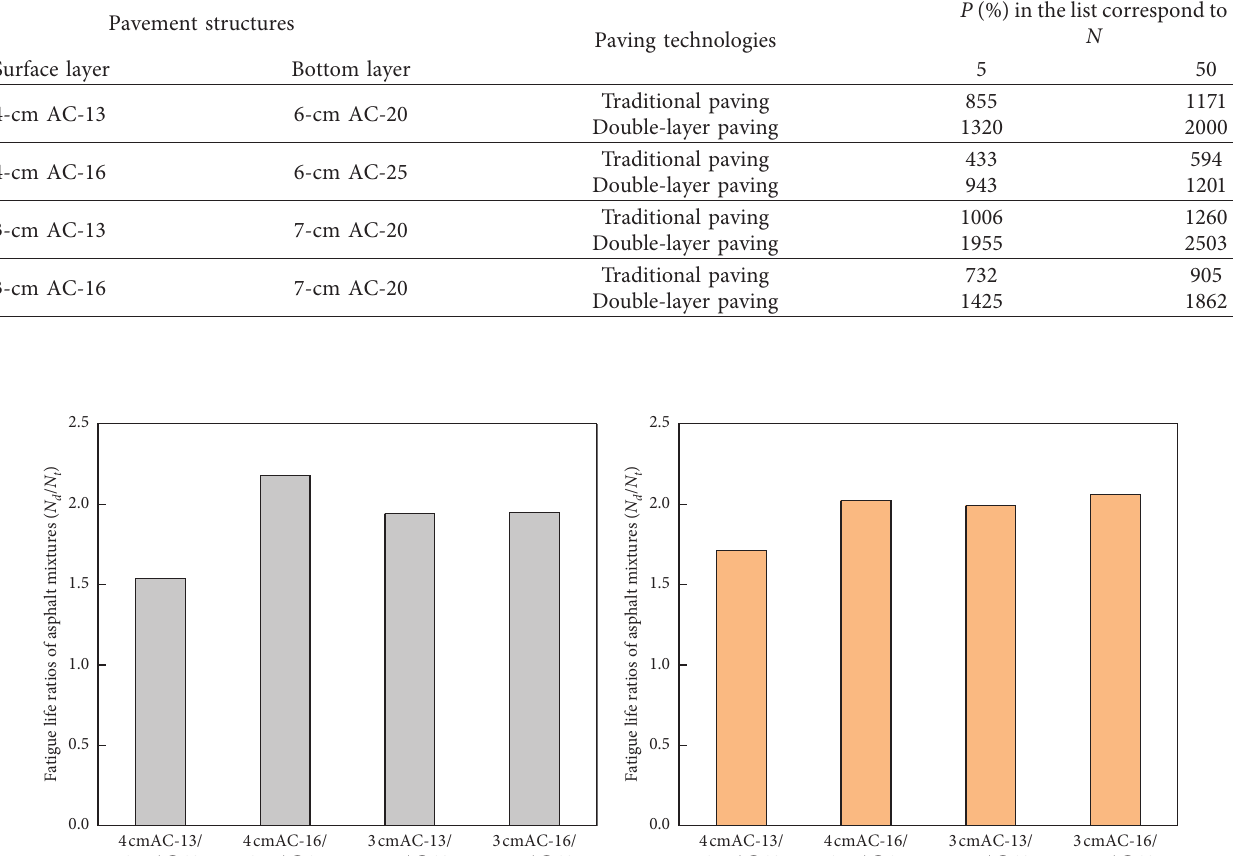
Table 9: Fatigue life of specimens with different paving technologies, mixture types, and pavement structural thicknesses. Pavement structures Paving technologies